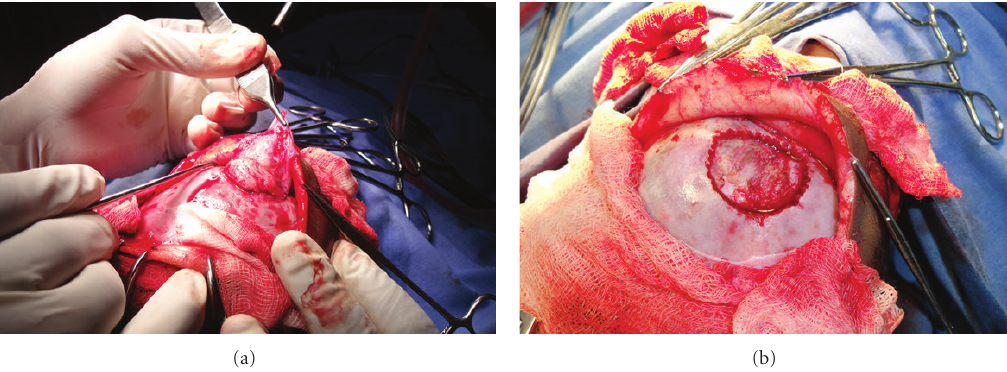
Figure 3: (a) Intraoperative image showing surgical excision of the lesion and (b) surgical site following excision.